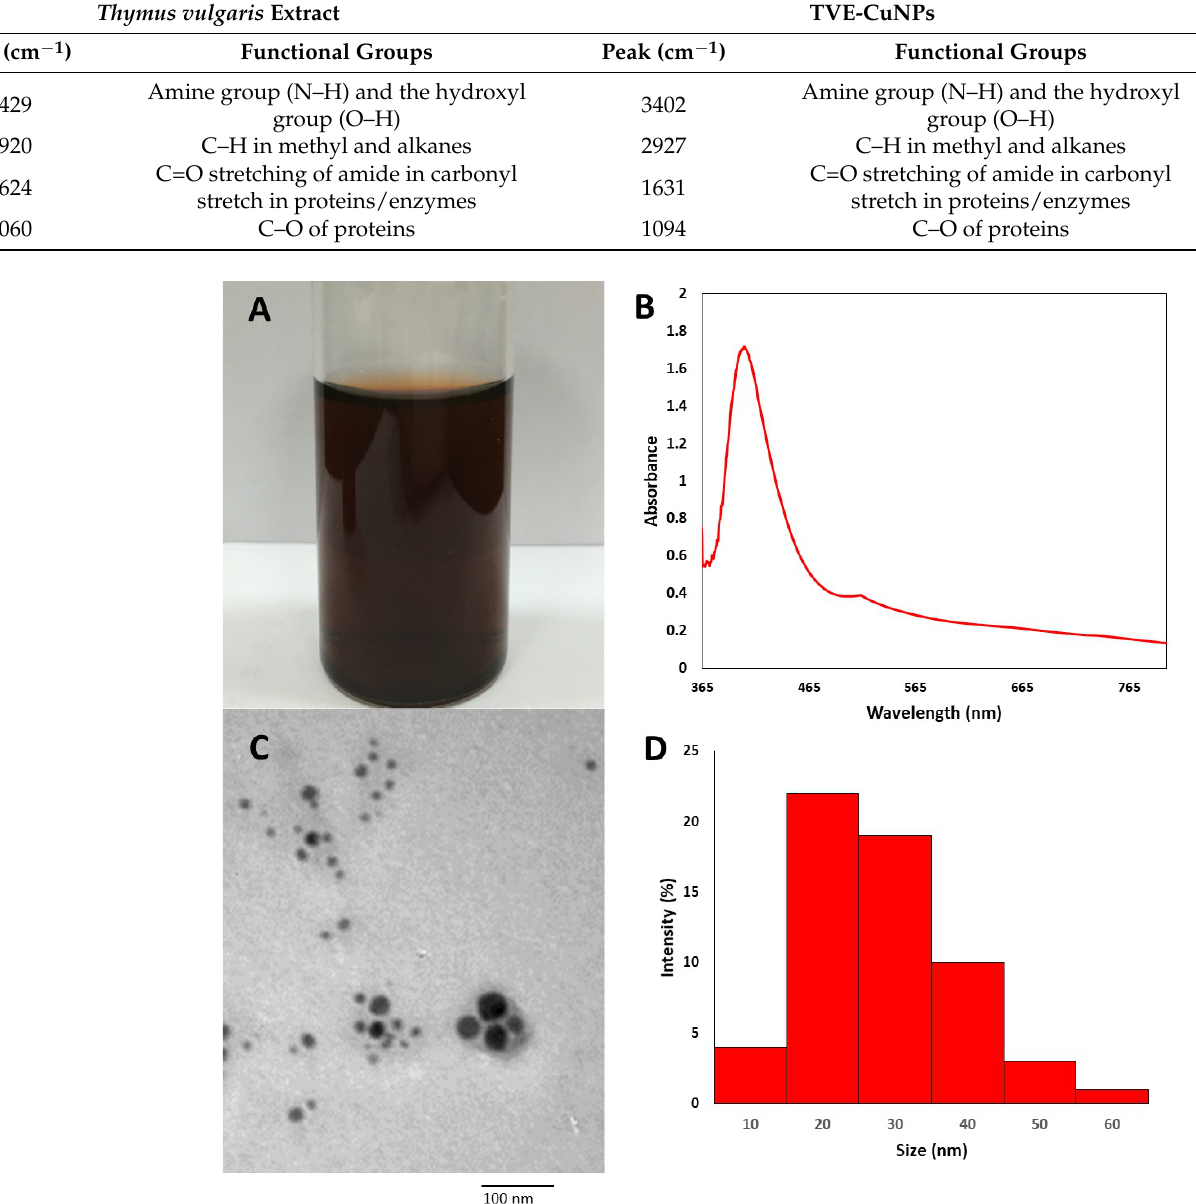
Table 1. Peaks were obtained by FTIR analysis and corresponding functional groups in Thymus vulgaris extract and TVE-CuNPs.